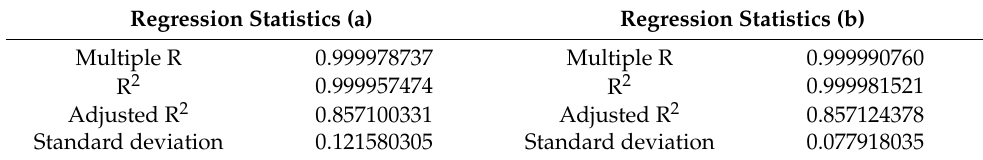
Table 4. Regression analysis of fuel injection set by the factory, and the Taguchi-Regression algorithm.